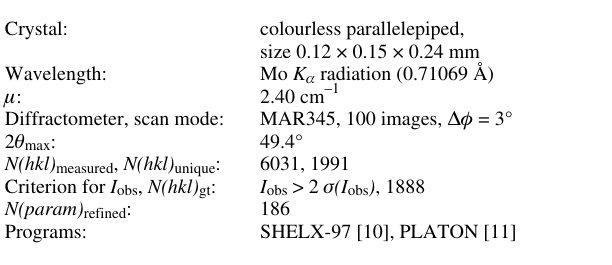
Table 1. Data collection and